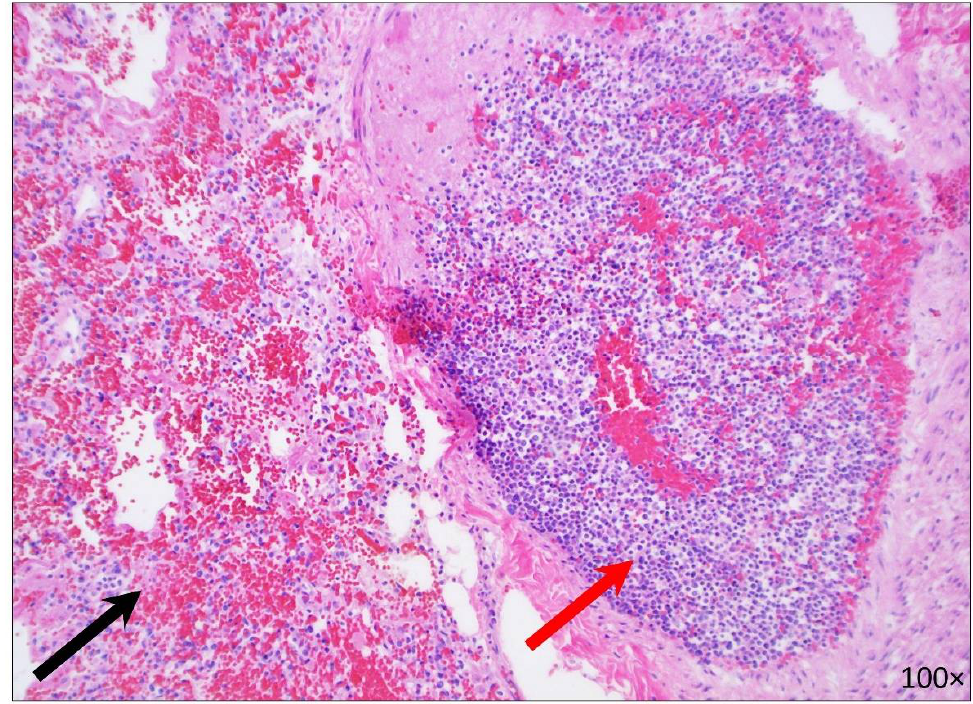
Figure 2. Microscopic image of the lung (RLL) showing intravascular AML infiltrates (red arrow) and diffuse intra-alveolar hemorrhages (black arrow) (100× magnification).